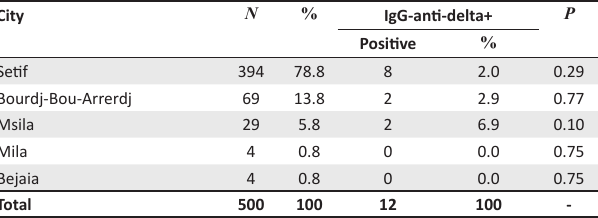
TABLE 2: Prevalence of HDV by city.